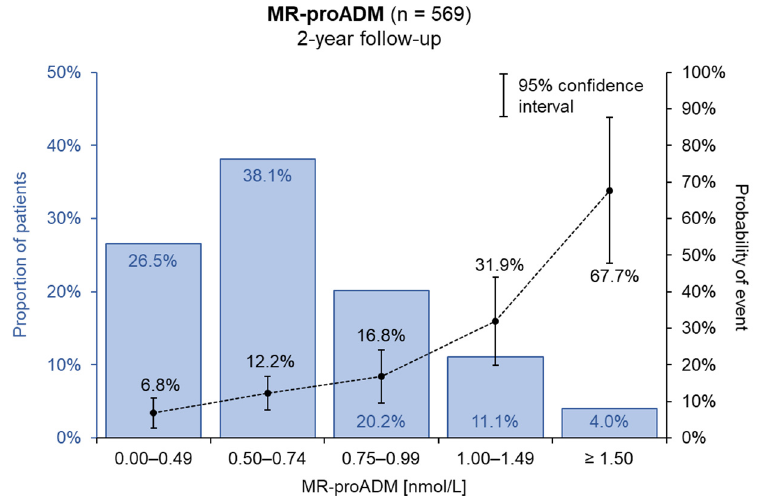
Figure 2. Two-year event-free survival.